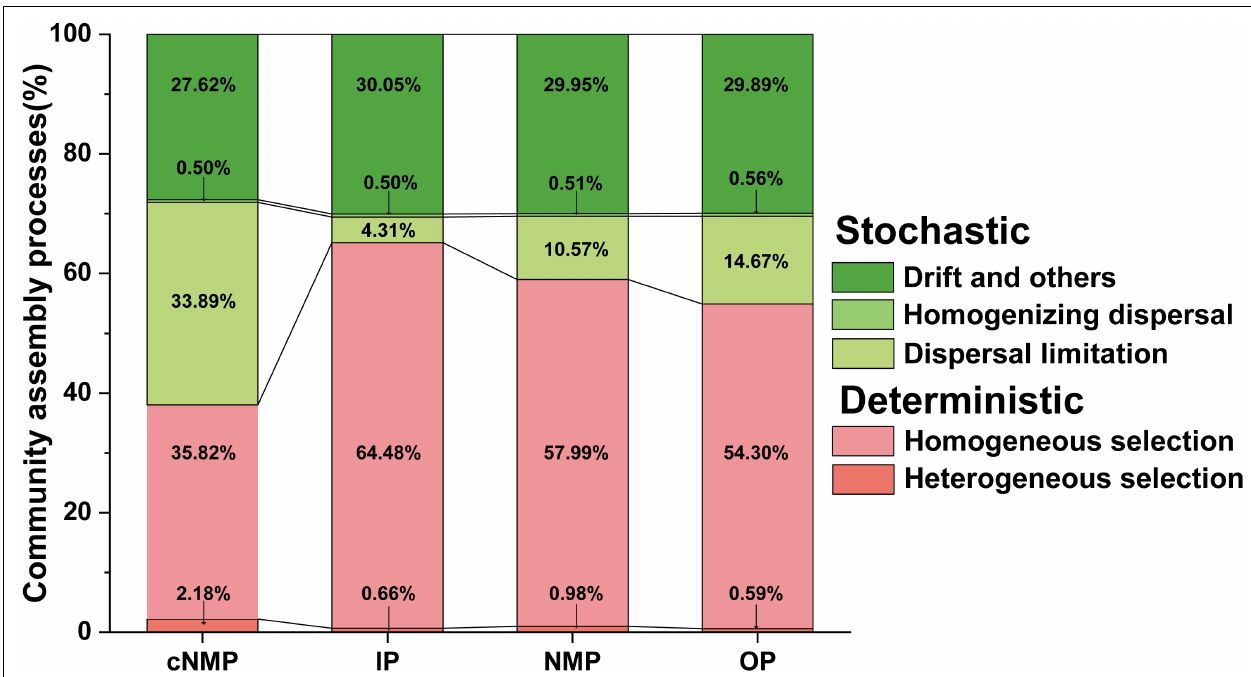
FIGURE 4 | The relative contribution of deterministic and stochastic processes under the change of bacterial community assembly in DPR with different phosphorus sources. Deterministic included heterogeneous selection and homogeneous selection. Stochastic included drift and others, homogenizing dispersal, and dispersal limitation. DPR, denitrifying phosphorus